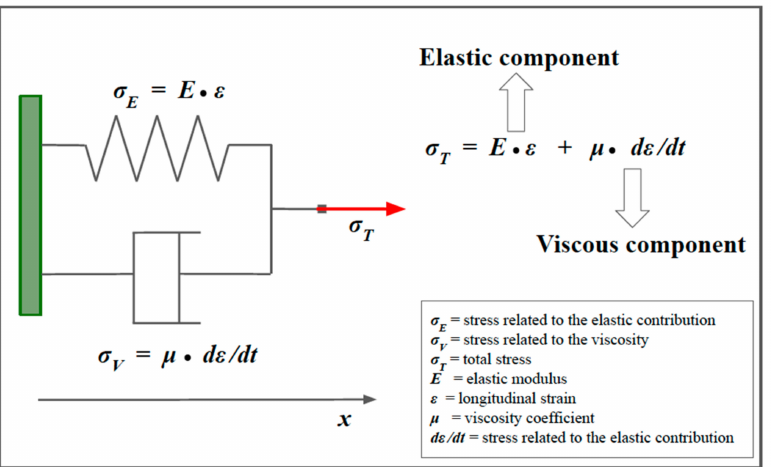
Figure 8. The concept of viscosity. A green plate flows from left to right on the surface of a fluid (light blue), pulled with a force of intensity, F . If there were no friction present, the plate would move with a uniformly accelerated motion; however, in reality, its speed tends to be constant over time since the force F is balanced by a friction force due to the sliding of the various layers of liquid (under the conditions of laminar motion). The viscous friction force acting on the plate has an intensity that is given by relation 1 and it is directly proportional to the sliding speed ( v ). From relation 1, it is easy to derive relation 2, as highlighted by the red arrow. It is worth noting that, unlike the shear stress in solids (relation 3), the shear deformation is not expressed as a longitudinal strain, but instead as a gradient of velocity, that is, the change in velocity with respect to the depth of the liquid. Red arrows highlight the similarities.